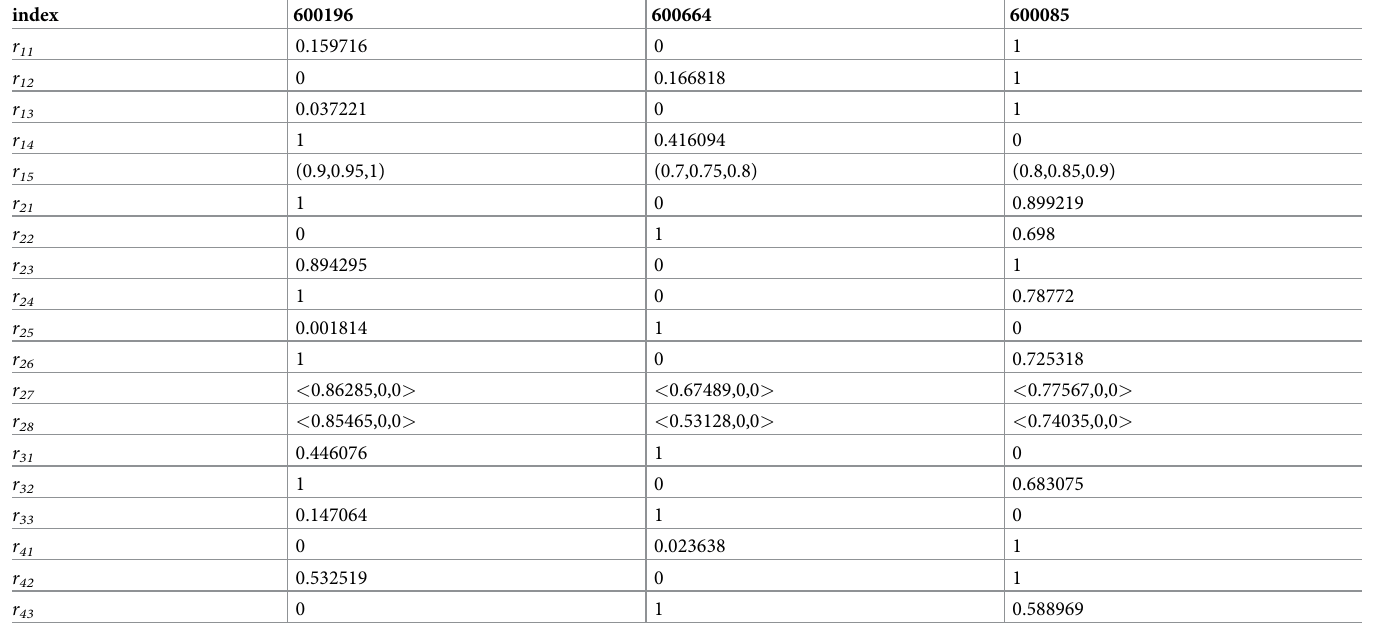
Table 10. Normalized evaluation